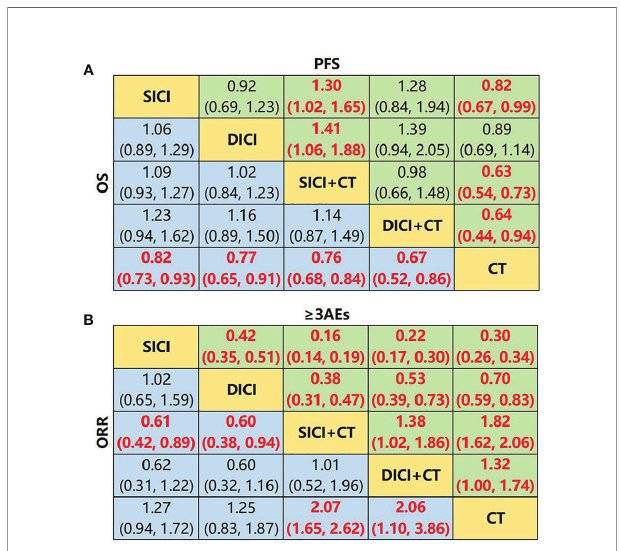
FIGURE 4 | Network meta-analysis of SICI, DICI, SICI+CT, DICI+CT, and CT. (A) Pooled hazard ratio (HR) [95% CrIs (credible intervals)] for overall survival (OS) and progression-free survival (PFS) in the overall population. (B) Pooled odds ratio (OR) (95% CrIs) for objective response rate (ORR) and adverse events of grade 3 or higher ( ≥ 3AEs) in the overall population. Data in each cell are HR or OR (95% CrIs) for the comparison of upper row-de fi ning treatment vs . lower row-de fi ning treatment. HR less than 1 and OR more than 1 favor upper-row treatment. Signi fi cant results are highlighted in red and bold. SICI, single immune checkpoint inhibitor; DICI, double immune checkpoint inhibitors; SICI+CT, single immune checkpoint inhibitor combined with chemotherapy; DICI+CT, double immune checkpoint inhibitors combined with chemotherapy; CT, chemotherapy.